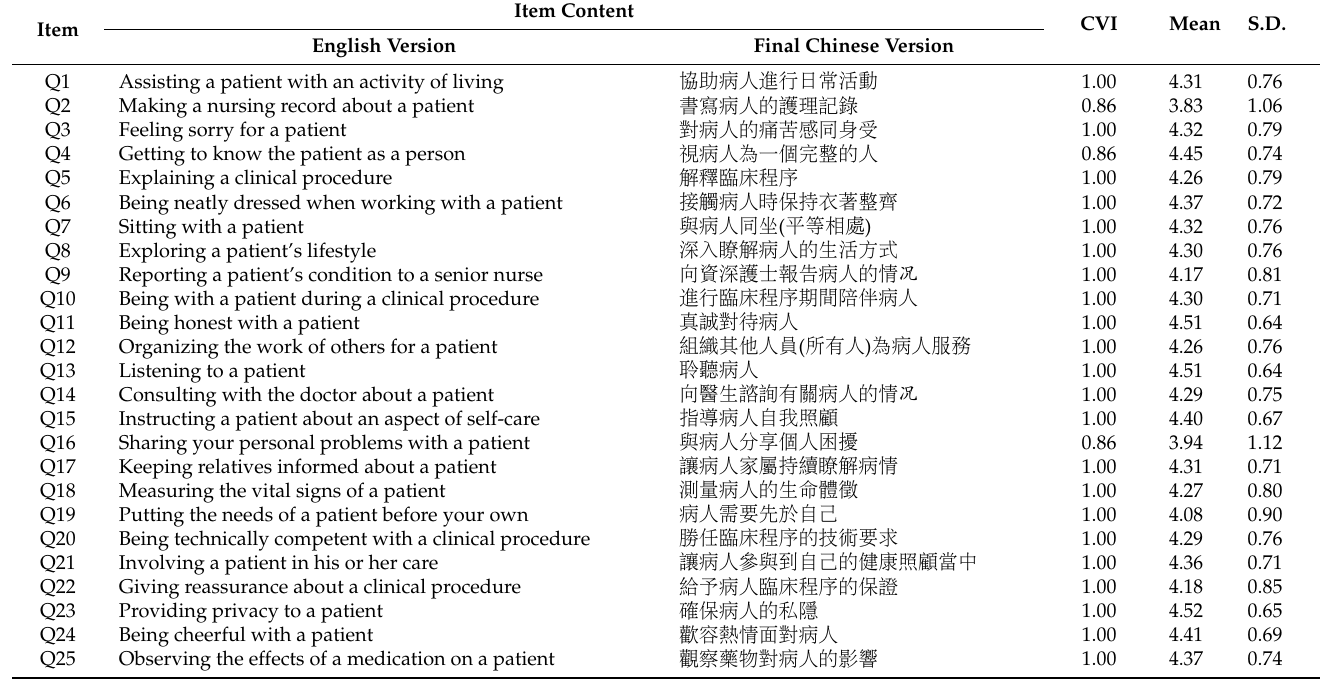
Table 2. The content, content validity index (CVI), means, standard deviations for CDI items (N = 880).